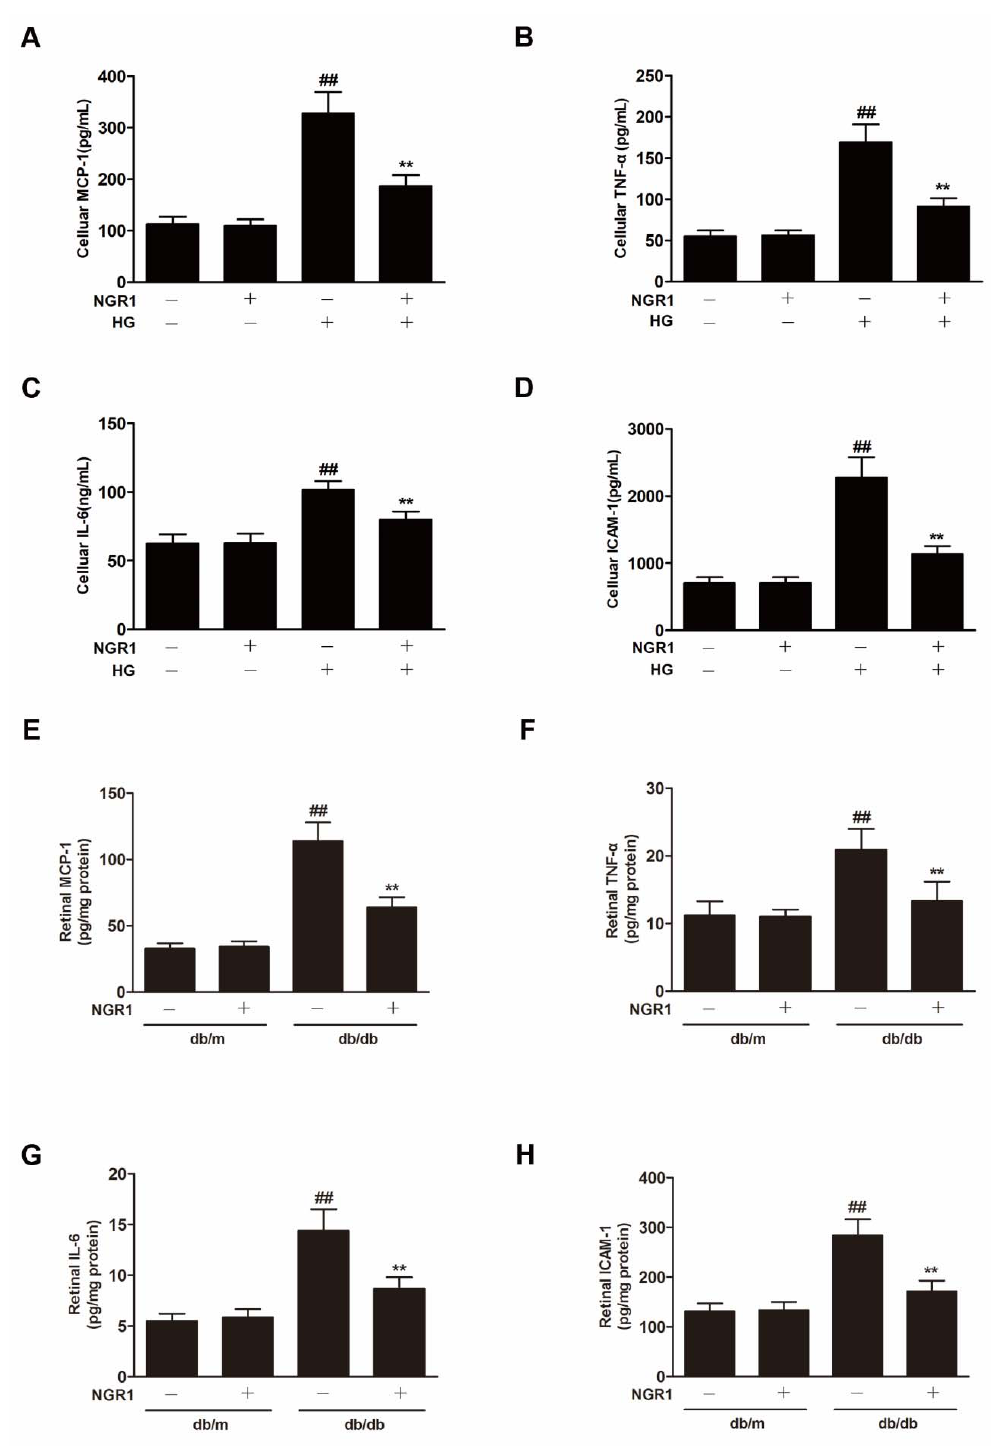
Figure 6. NGR1 pretreatment significantly inhibited inflammation in vivo and in intro. NGR1 preconditioning significantly inhibited HG-induced production of MCP-1 ( A ), TNF- α ( B ), IL-6 ( C ), and ICAM-1 ( D ) in rMC cells. NGR1 pretreatment significantly decreased the levels of MCP-1 ( E ), TNF- α ( F ), IL-6 ( G ), and ICAM-1 ( H ) in the retina of db/db mice. The levels of MCP-1, TNF- α , IL-6, and ICAM-1 were detected by ELISA. The results are expressed as the means ± SD (n = 10). ## indicates a significant difference from control cells or db/m mice ( p < 0.01). ** indicates a significant difference from the HG treatment or db/db mice ( p < 0.01). (+), treatment with HG or NGR1; ( − ), treatment without HG or